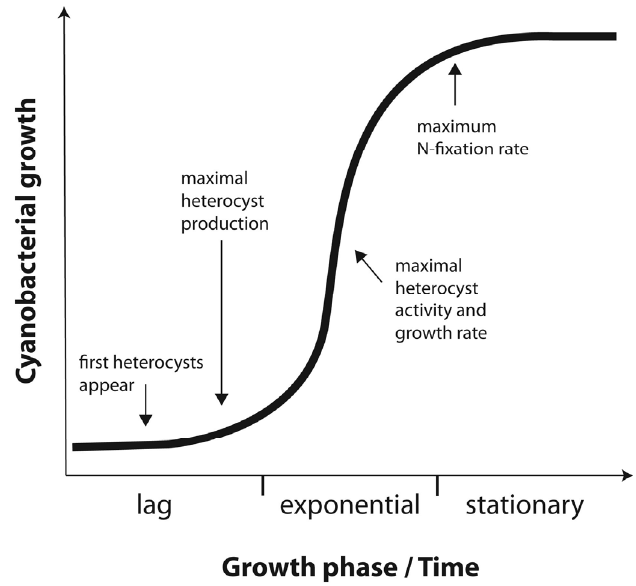
Figure 6. Timeline of growth and N fixation events for the cyanobacterium N. punctiforme grown under axenic conditions. During the lag phase of growth, the cyanobacteria produces heterocyst cells alongside vegetative cell growth; heterocyst cell production occurs within 1–3 days. The maximum rate of heterocyst production occurs while the cyanobacteria is still in lag phase, but just before exponential growth, which is characterized by the highest growth rate and maximal per cell heterocyst N fixation activity. Once the cyanobacteria reach the stationary phase, overall N fixation is highest due to the greatest amounts of total heterocyst cells.